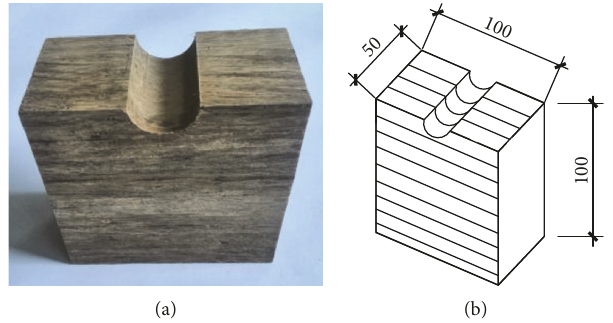
Figure 2: Drawing details of the specimen.